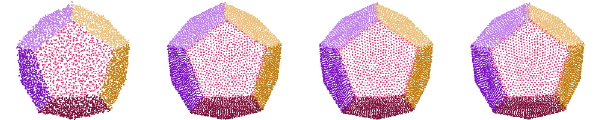
Fig. 15 Filtered results for different number of iterations. Noise level: 1.0%, k = 30, µ =